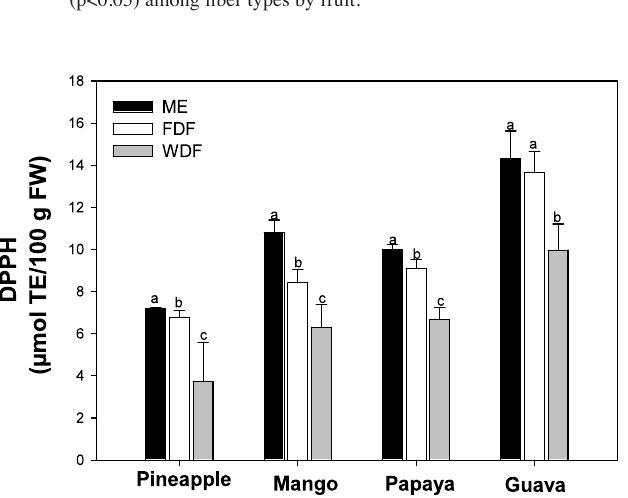
Fig. 3: Radical scavenging activity assessed by the DPPH assay, of metha- nolic extracts (ME) of tropical fruits by adding fruit dietary fiber (FDF) and wheat dietary fiber (WDF). Different letter in the same fruit indicates significant difference (p<0.05) between fiber types.